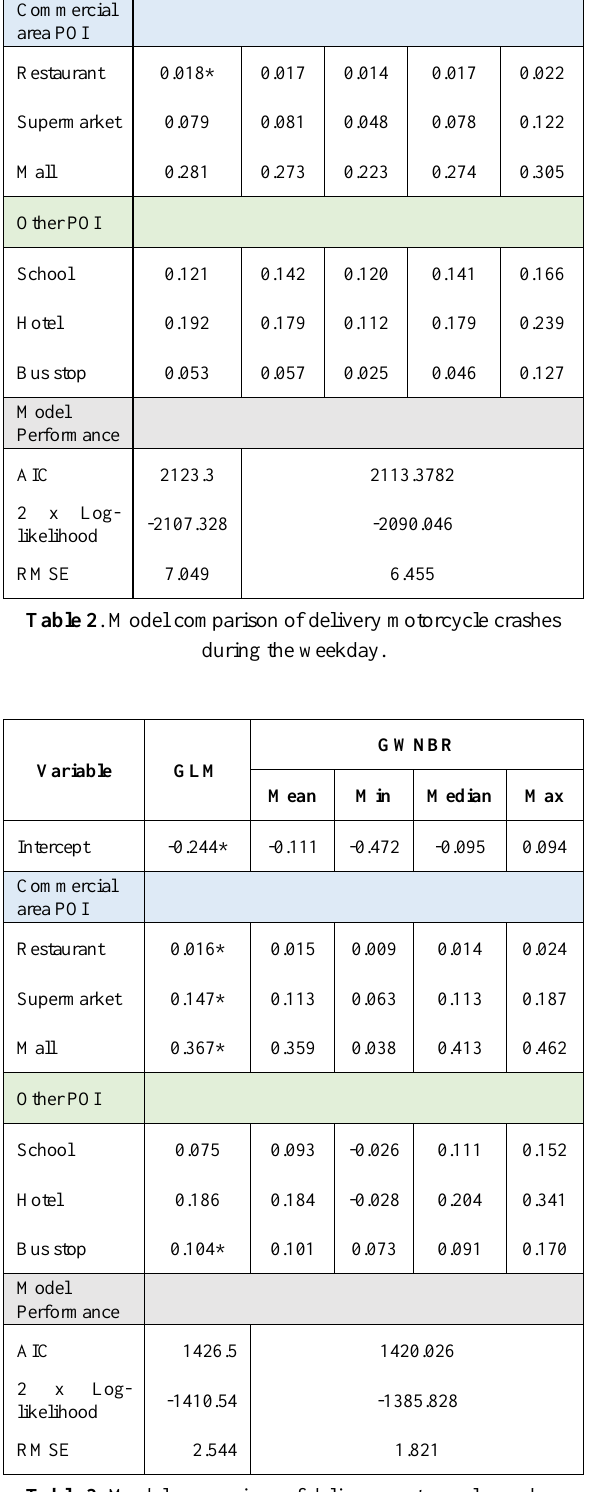
Table 3 . Model comparison of delivery motorcycle crashes during the